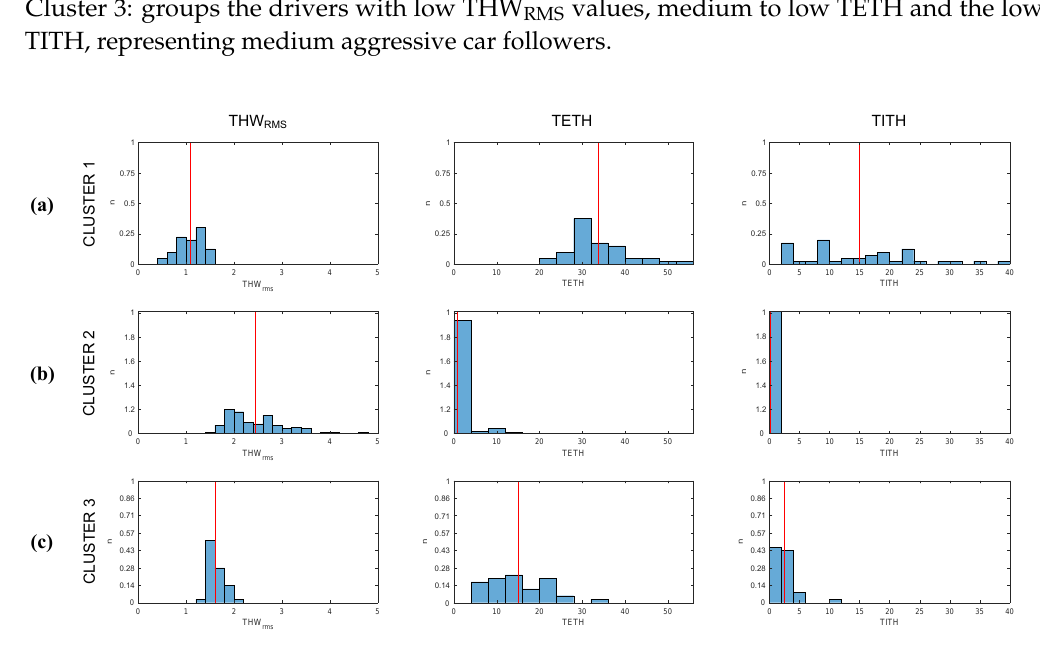
Figure 6. Histogram of THW RMS , TETH, and TITH values distribution for ( a ) Cluster 1, ( b ) Cluster 2, and ( c ) Cluster 3. Red line represents average value of each